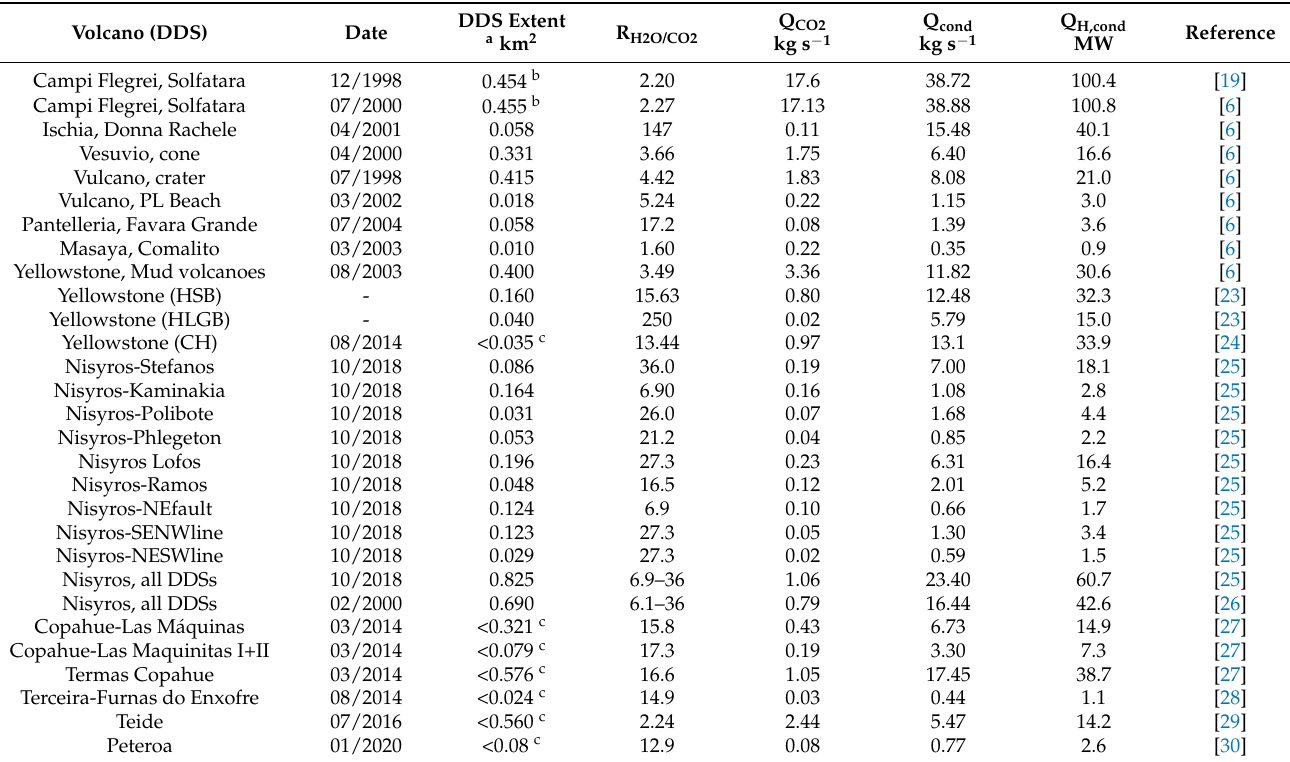
Table 1. Thermal energy associated with the CO 2 degassing from hot soils from some geothermal/hydrothermal systems and relevant parameters for its calculation.